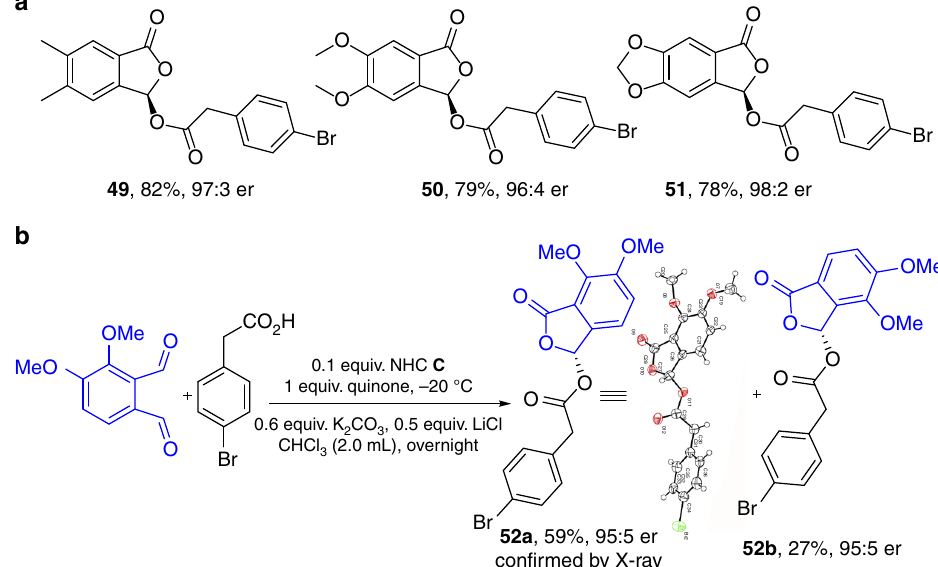
Fig. 4 Scope of dialdehydes and regioselectivity study. a substituted aldehydes. b unsymmetic dialdehyde (regioselectivity